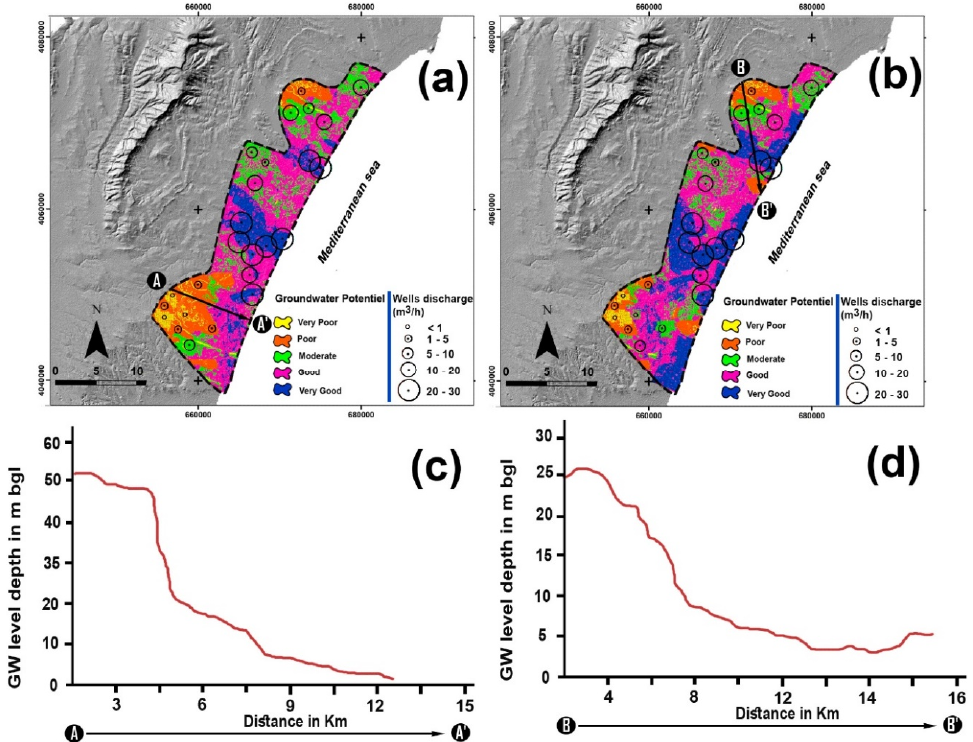
Figure 8. Groundwater recharge zones of the Korba area: (( a ) using AHP method and ( b ) MIF technique) and validation of groundwater recharge zones through comparison with water level profile in different parts of the study area: ( c ) AA’ for AHP and ( d ) BB’ for MIF, respectively, indicated the W-E and NW-SE directions.